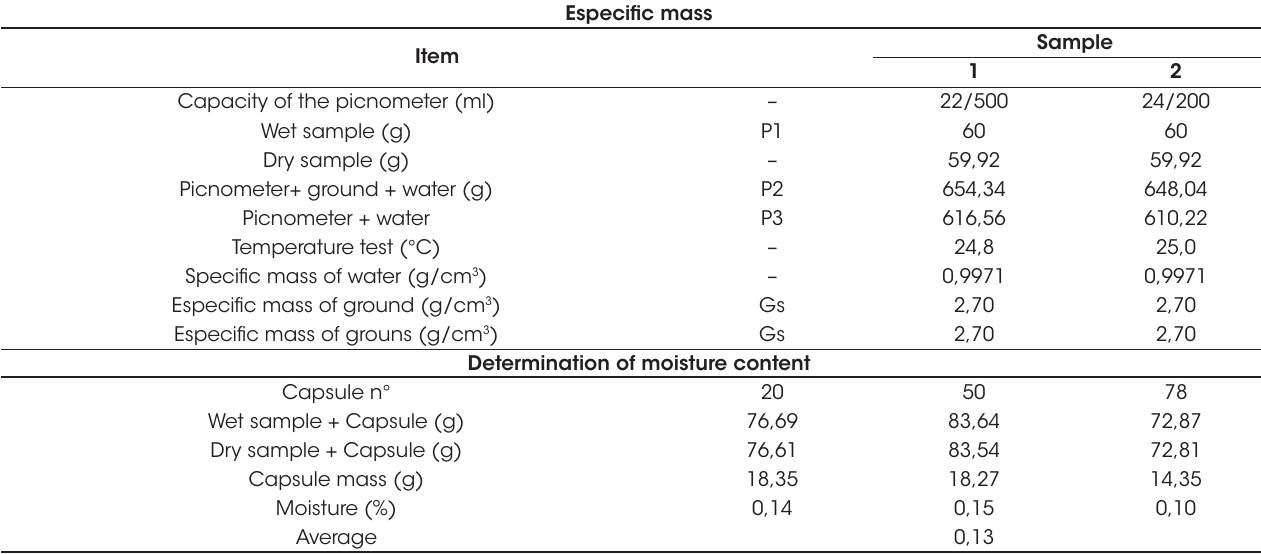
Specific mass and moisture content of CBC